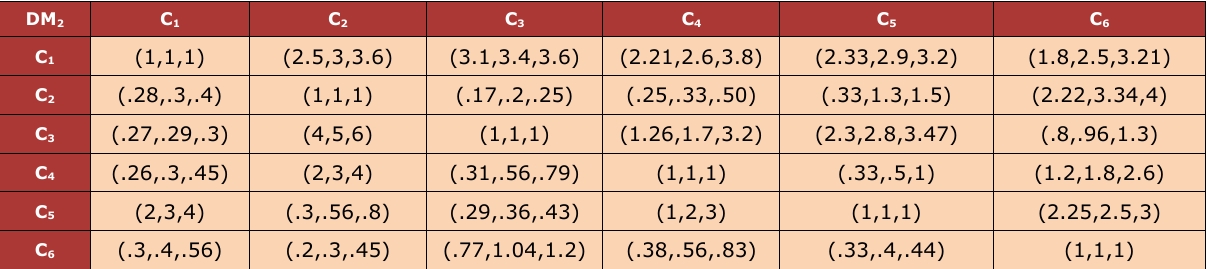
Table 3. Pair-wise comparison of second decision maker